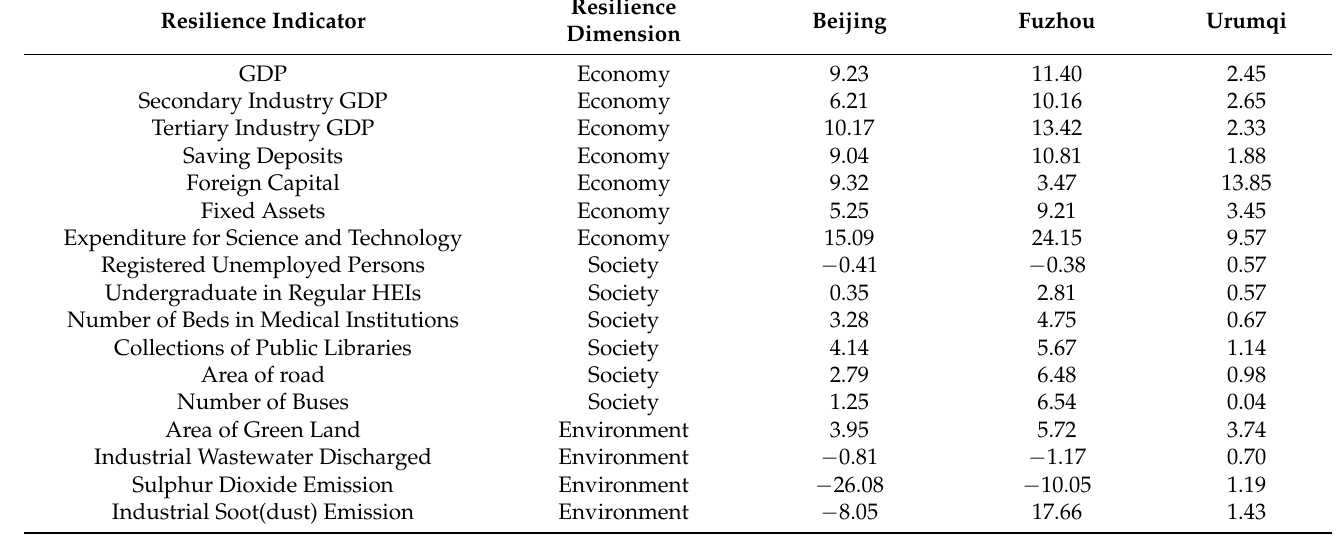
Table 3. Allometric growth of resilience indicators in Beijing, Fuzhou, and Urumqi from 2006 to 2019.